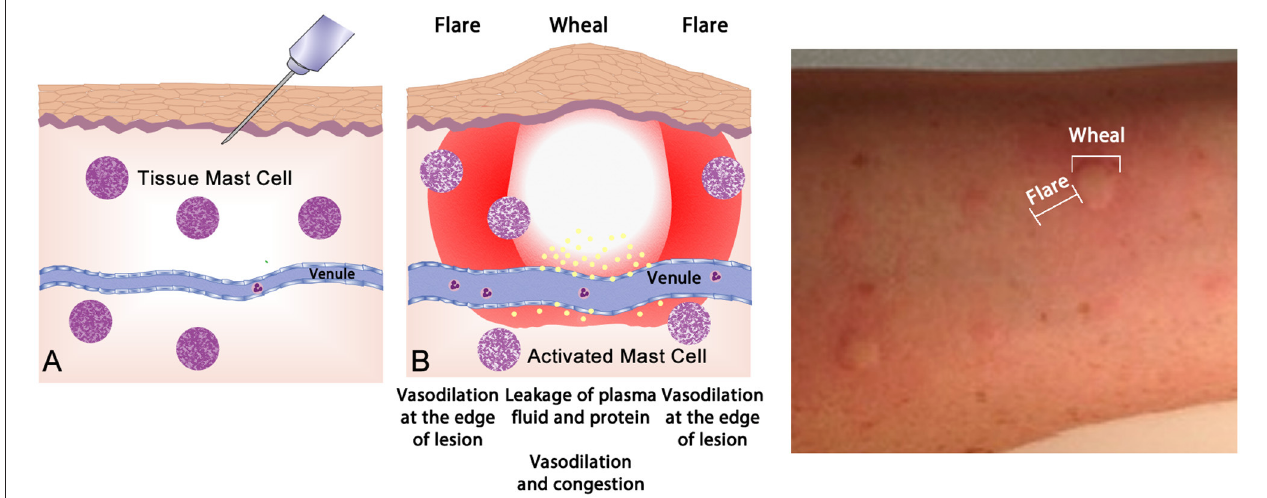
FIGURE 4 | The wheal-and-flare reaction in the skin. (A) Normal basal or a non-reactive state for mast cells in tissue. The needle injects a known allergic antigen or allergen. (B) Antigens provoking allergic reactions drive specific-IgE production by plasma cells, assisted by TH2 cells. Surface bound IgE on mast cells is cross-linked by secondary exposure to allergen, causing release of preformed (e.g., histamine) and lipid-derived (e.g., leukotriene) mediators which drive the vascular events of allergy (vasodilatation and vascular fluid leak) manifesting as a “wheal and flare.” This photograph depicts a typical wheal-and-flare reaction in the skin in response allergen injection.